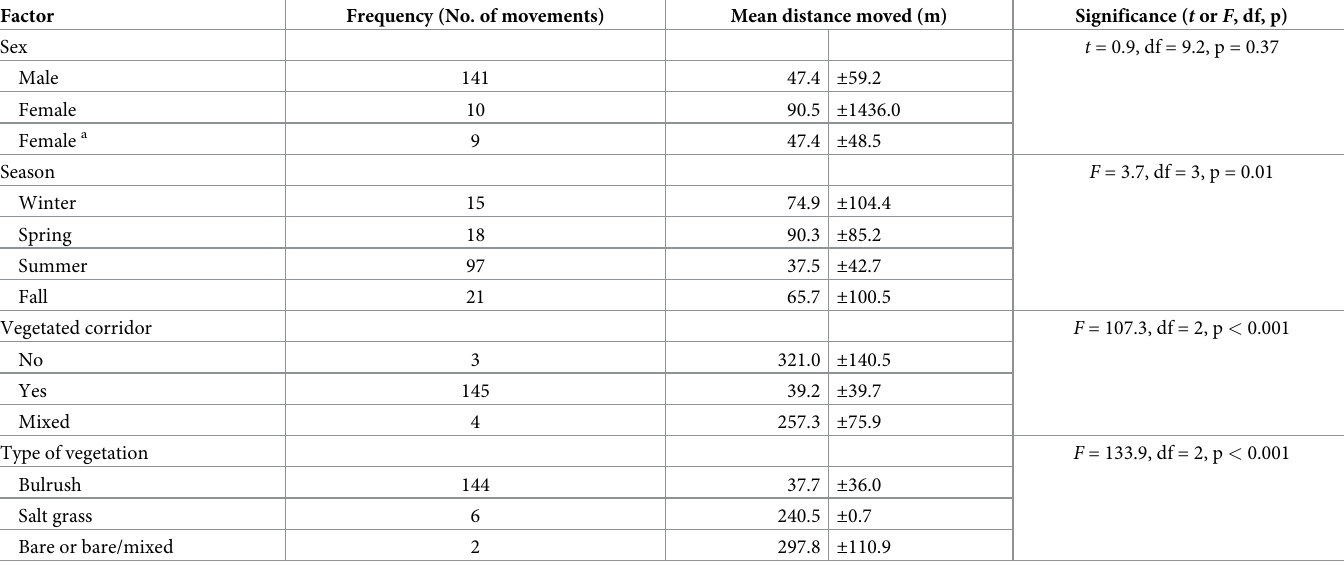
Table 3. Summary of movement patterns of 22 Amargosa voles that moved between different marshes near Tecopa, California.